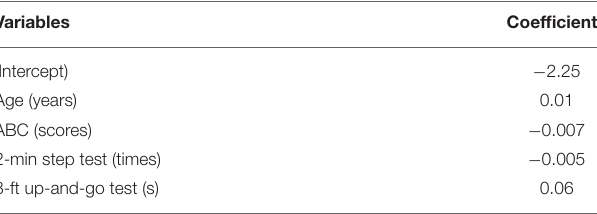
TABLE 3 | The estimated coefficients for LASSO regression between sex, age, BMI, and HRPF variables with self-reported falls.